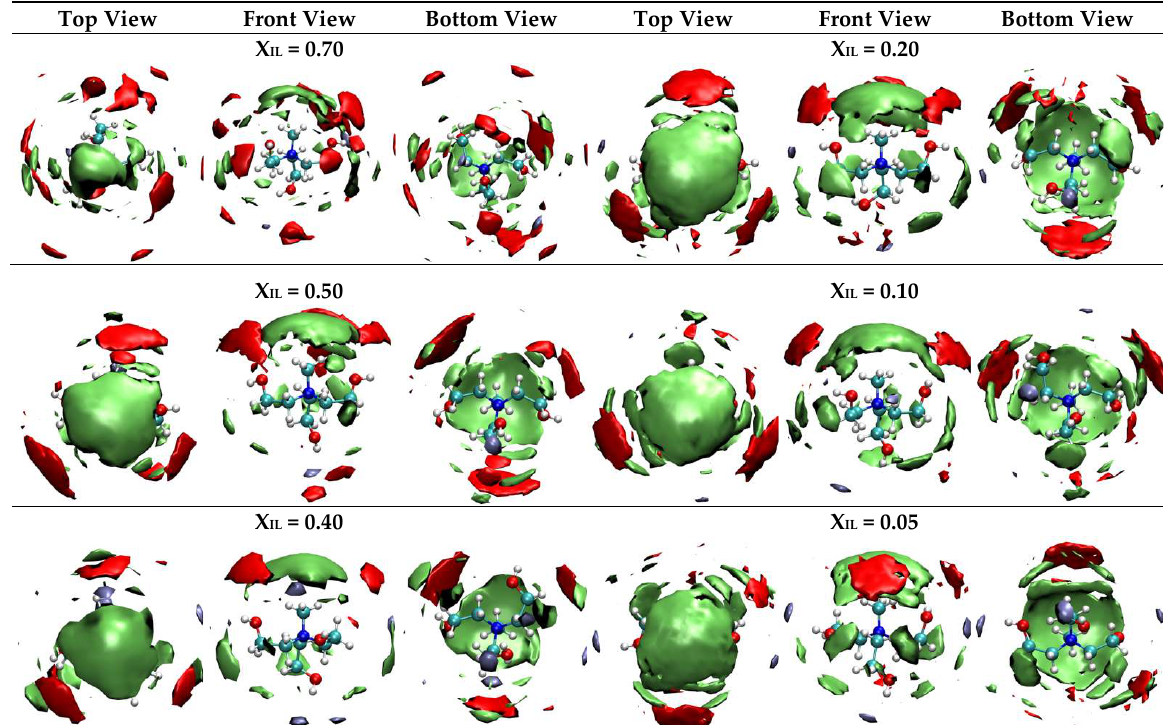
Figure 14. Total structure factor functions, S ( q ) in arbitrary units, of [N 1 2OH 2OH 2OH ][NTf 2 ] aqueous mixtures as a function of mole fraction of water.